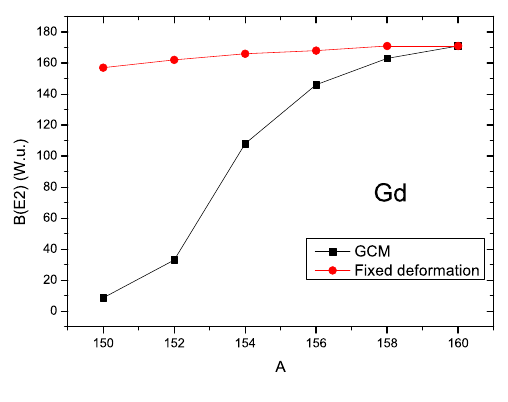
Figure 6. (Color online) Comparison of two calculations for B ( E 2) transitions from the first 2 + state to the ground state for 150 − 160 Gd: black squares corresponding to the full GCM calcula- tion and red dots to the calculation with a fixed